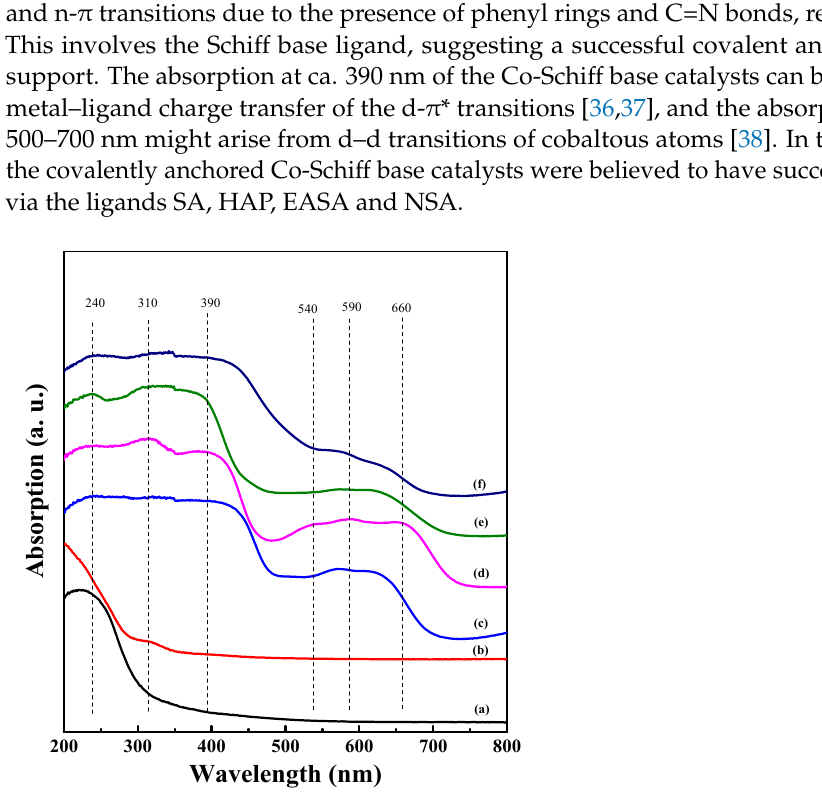
Figure 3. UV ‐ Vis spectra of the support SiO 2 (a), the intermediate SiO 2 ‐ APTES (b) and the covalently Figure 3. UV-Vis spectra of the support SiO 2 (a), the intermediate SiO 2 -APTES (b) and the covalently anchored catalysts SiO 2 ‐ APTES ‐ SA ‐ Co (c), SiO 2 ‐ APTES ‐ HAP ‐ Co (d), SiO 2 ‐ APTES ‐ EASA ‐ Co (e) and anchored catalysts SiO 2 -APTES-SA-Co (c), SiO 2 -APTES-HAP-Co (d), SiO 2 -APTES-EASA-Co (e) and SiO 2 ‐ APTES ‐ NSA ‐ Co (f). SiO 2 -APTES-NSA-Co